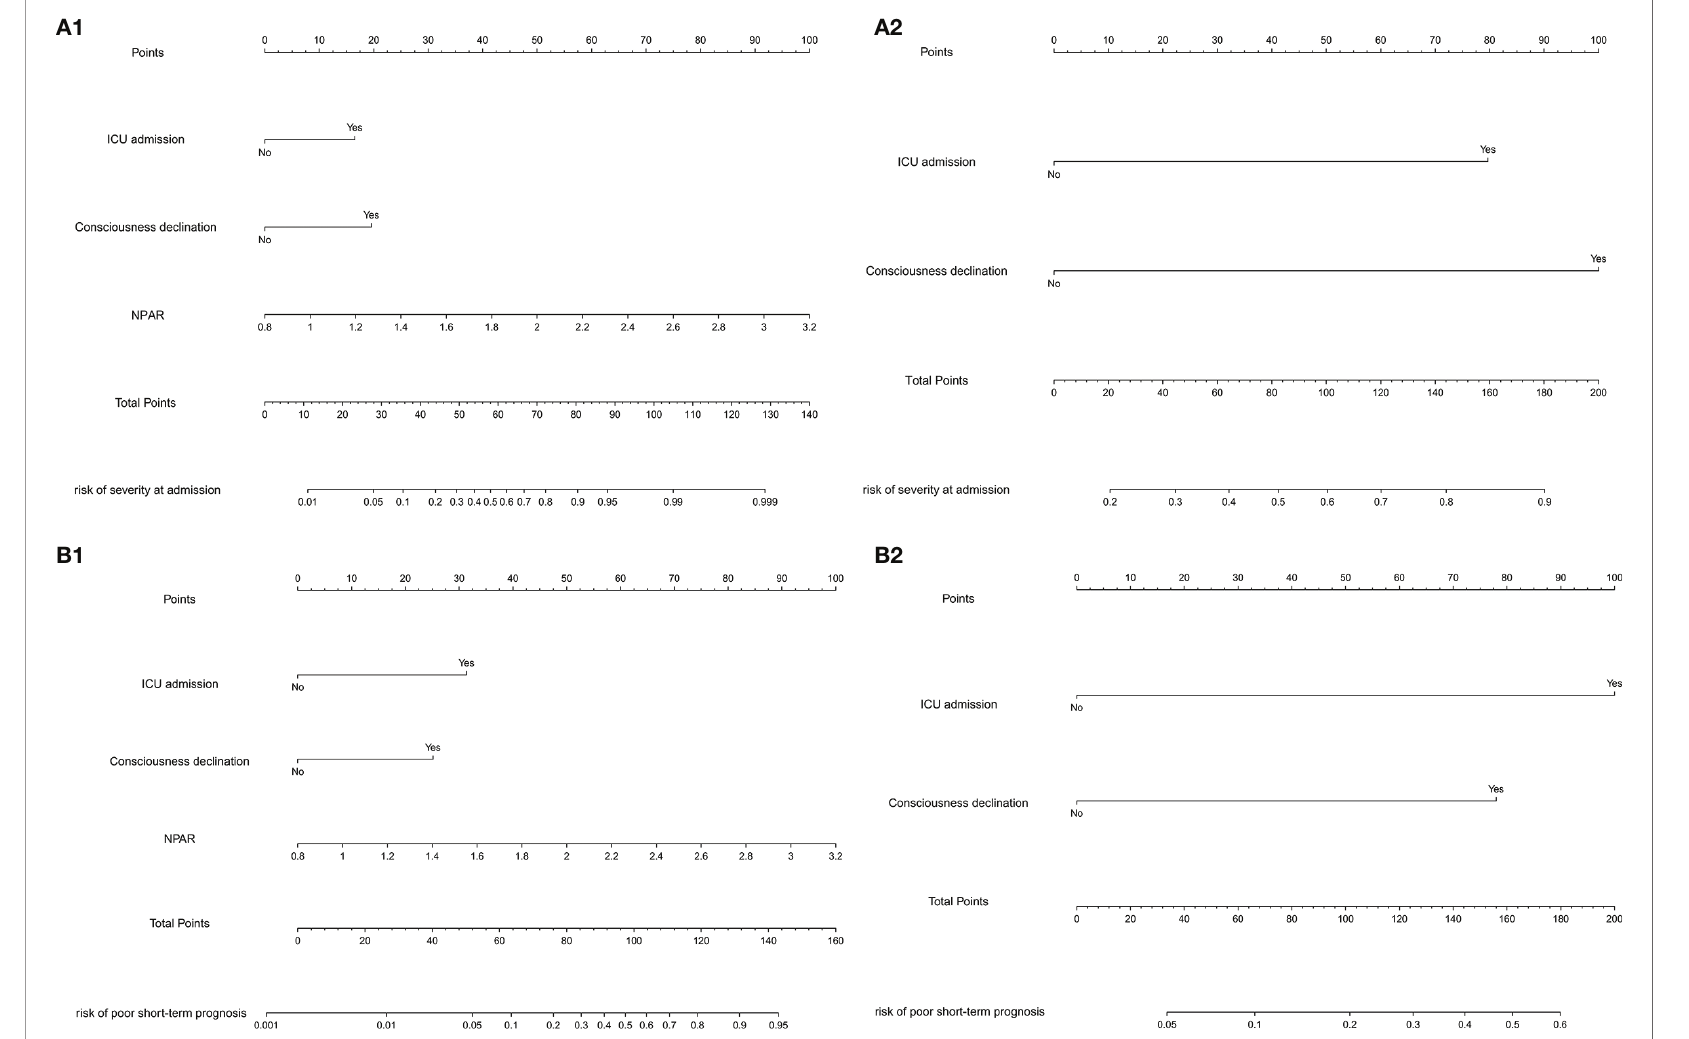
FIGURE 9 | (A1) Nomogram including NPAR for assessing disease severity at admission. (A2) Nomogram without NPAR for assessing severity at admission. (B1) Nomogram including NPAR for predicting short- term prognosis. (B2) Nomogram without NPAR for predicting short-term